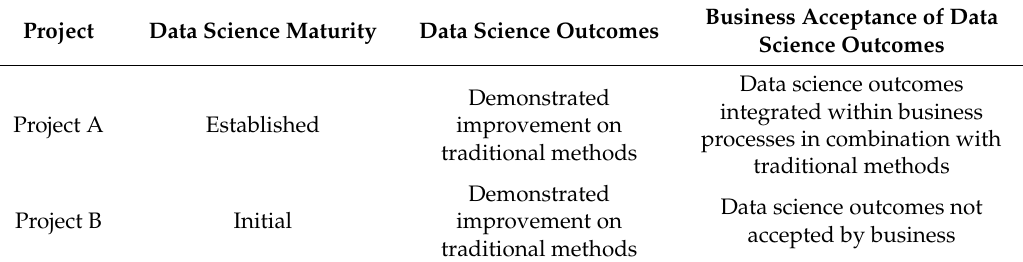
Table 2. Comparison of the case studies.